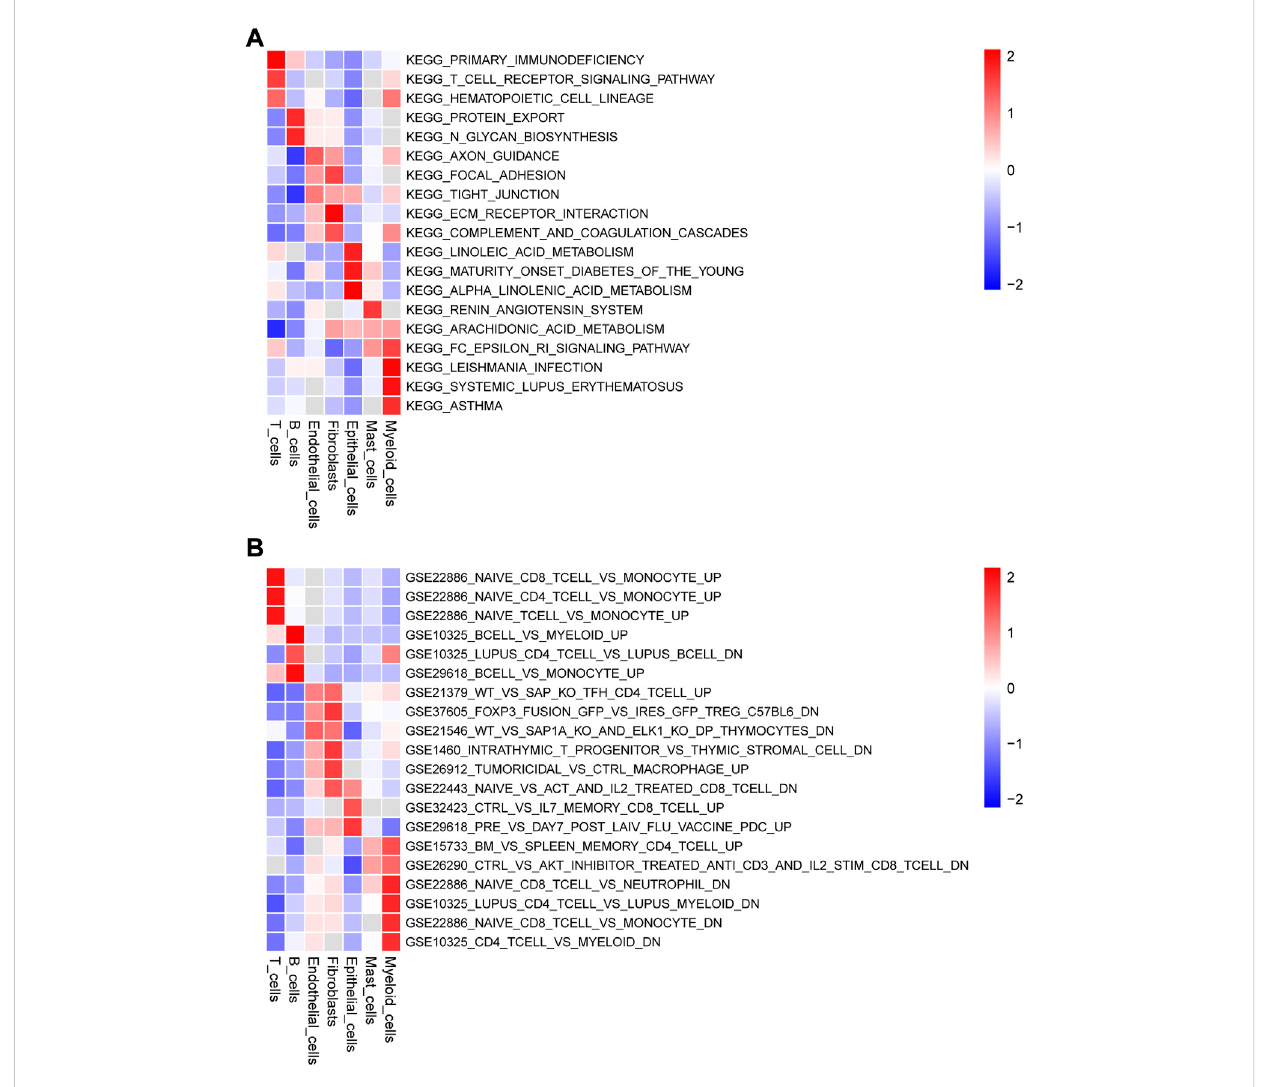
FIGURE 3 Gene set variation analysis (GSVA) of the signi fi cantly enriched signaling pathways (Top 3) among the seven types cells using (A) c2.cp.kegg.v7.5.1.symbols.gmt and (B) c7.immunesigdb.v7.5.1.symbols.gmt as reference gene